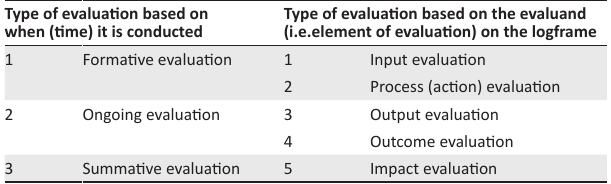
TABLE 1: Classification of the major types of evaluation found in the